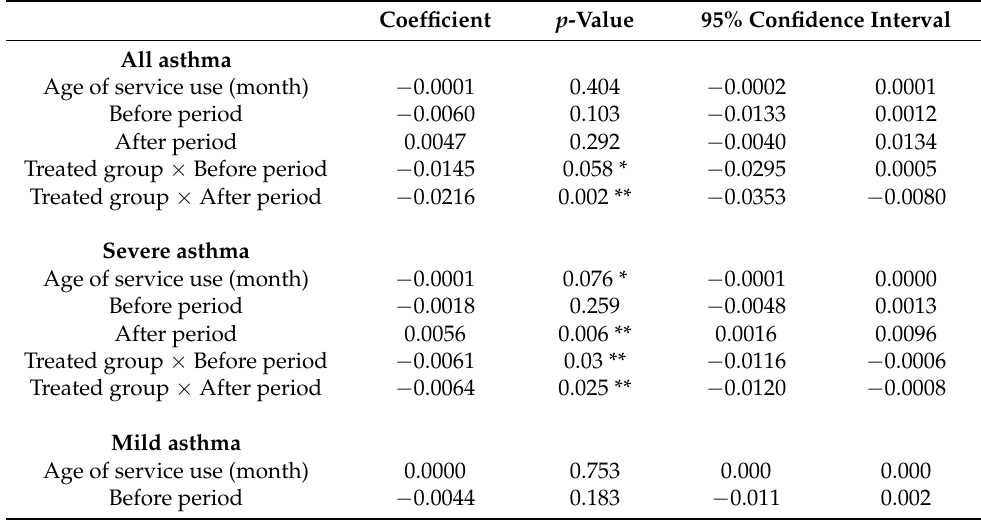
Table 3. Predicted coefficient of the interaction term of treated groups and period; pre vs. during and during vs.